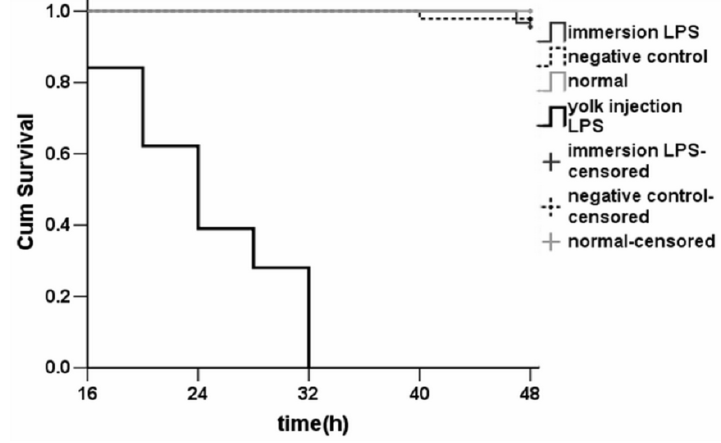
Figure 5. Average cumulative mortality (percent) of 3-dpf zebrafish larvae by different routes of LPS exposure. 3-dpf zebrafish larvae were exposed to 0.5 mg/mL LPS by immersion ( n = 34, p < 0.001) or injection into the yolk ( n = 34, p < 0.001), and monitored for 48 h. Negative controls were injected with PBS. Each curve represents data pooled from three independent